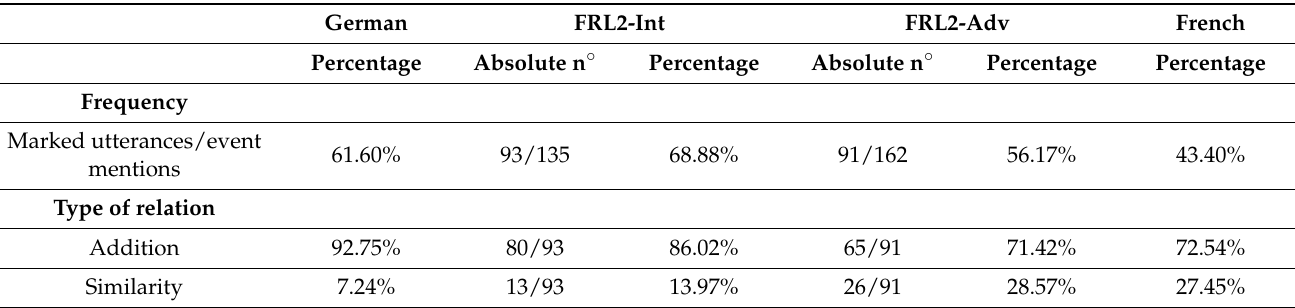
Table 5. Proportion of marked utterances in French L2.